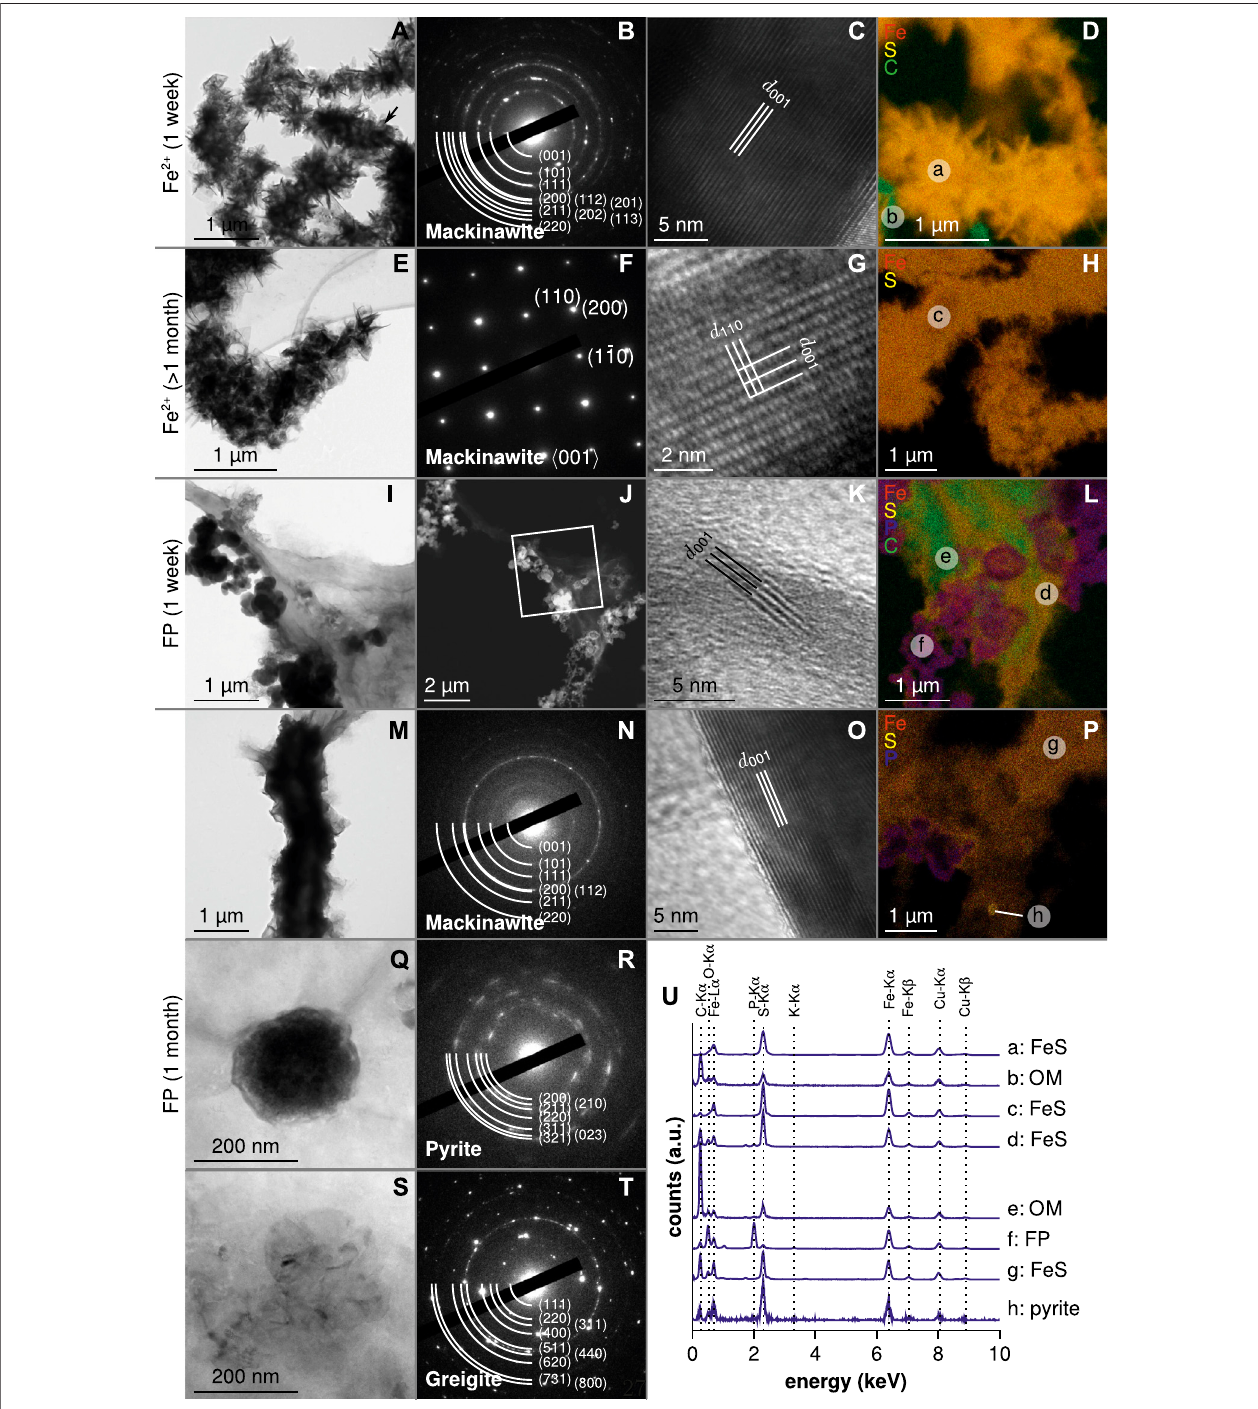
FIGURE 4 | Transmission electron microscopy observation of precipitates for both conditions, after 1 week and 1 month. Transmission electron microscopy, selected-area electron diffraction (orscanning transmission electron microscopyfor J panel),high-resolution images and energy dispersive X-ray spectrometry map for: (A – D) Fe-diss condition at 1 week, (E – H) Fe-diss condition at 8 months, (I – L) FP-nano condition at 1 week, and (M – T) FP-nano condition at 1 month. (U) Energy dispersive X-ray spectrometry spectra pinned from previous energy dispersive X-ray spectrometry maps. Letters in energy dispersive X-ray spectrometry maps correspond to energy dispersive X-ray spectrometry spectra provided in (U) .